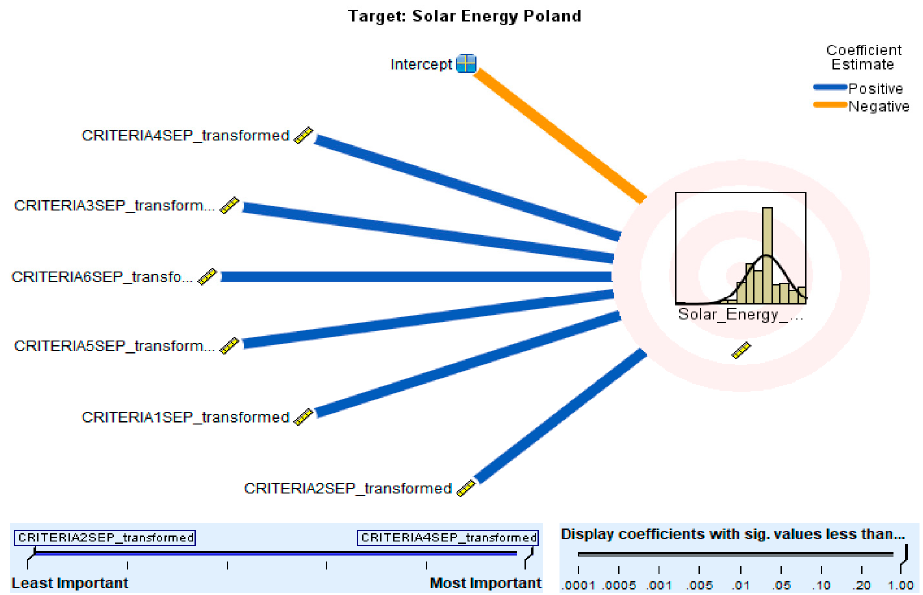
Figure 6. SE Poland GCV Criteria. Source: ALM Analysis SPSS by Author.